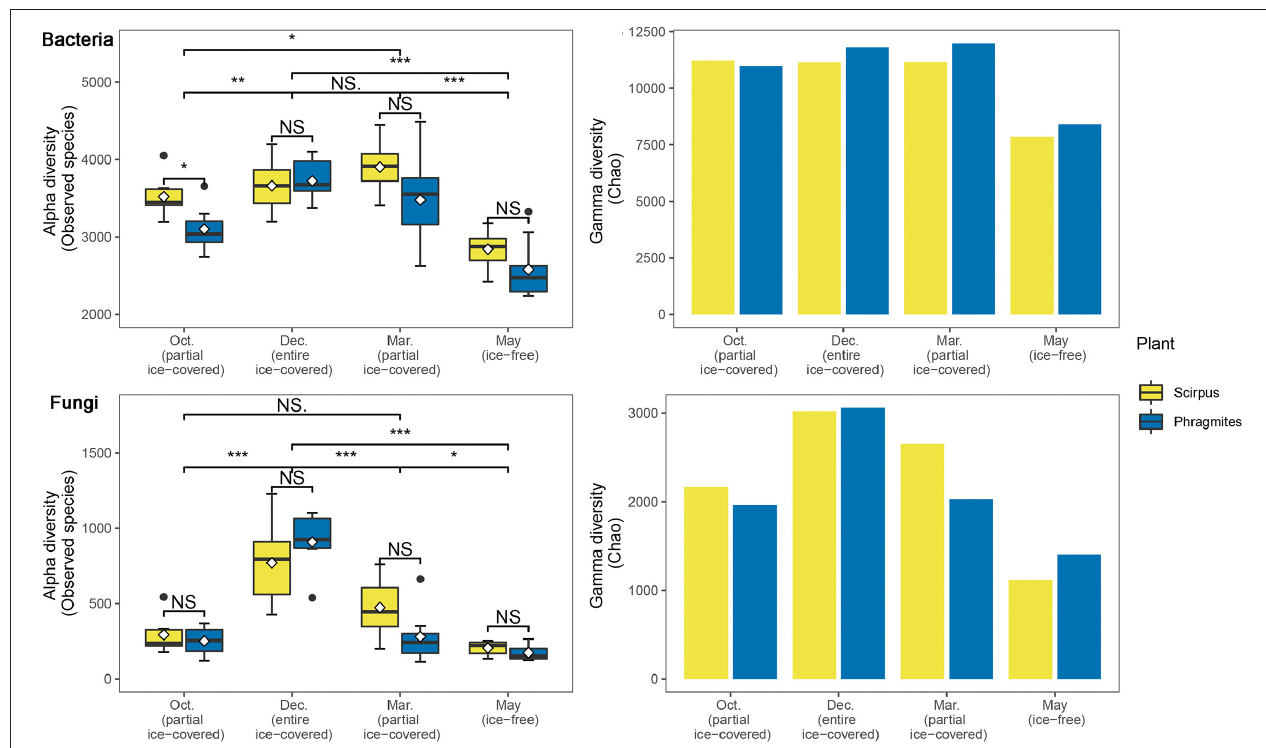
FIGURE 1 | Alpha and gamma diversities of bacterial and fungal communities during different ice-covered stages. Significance of the Wilcoxon signed-rank test: NS., not-significant; * p < 0.05; ** p < 0.01; *** p < 0.001.